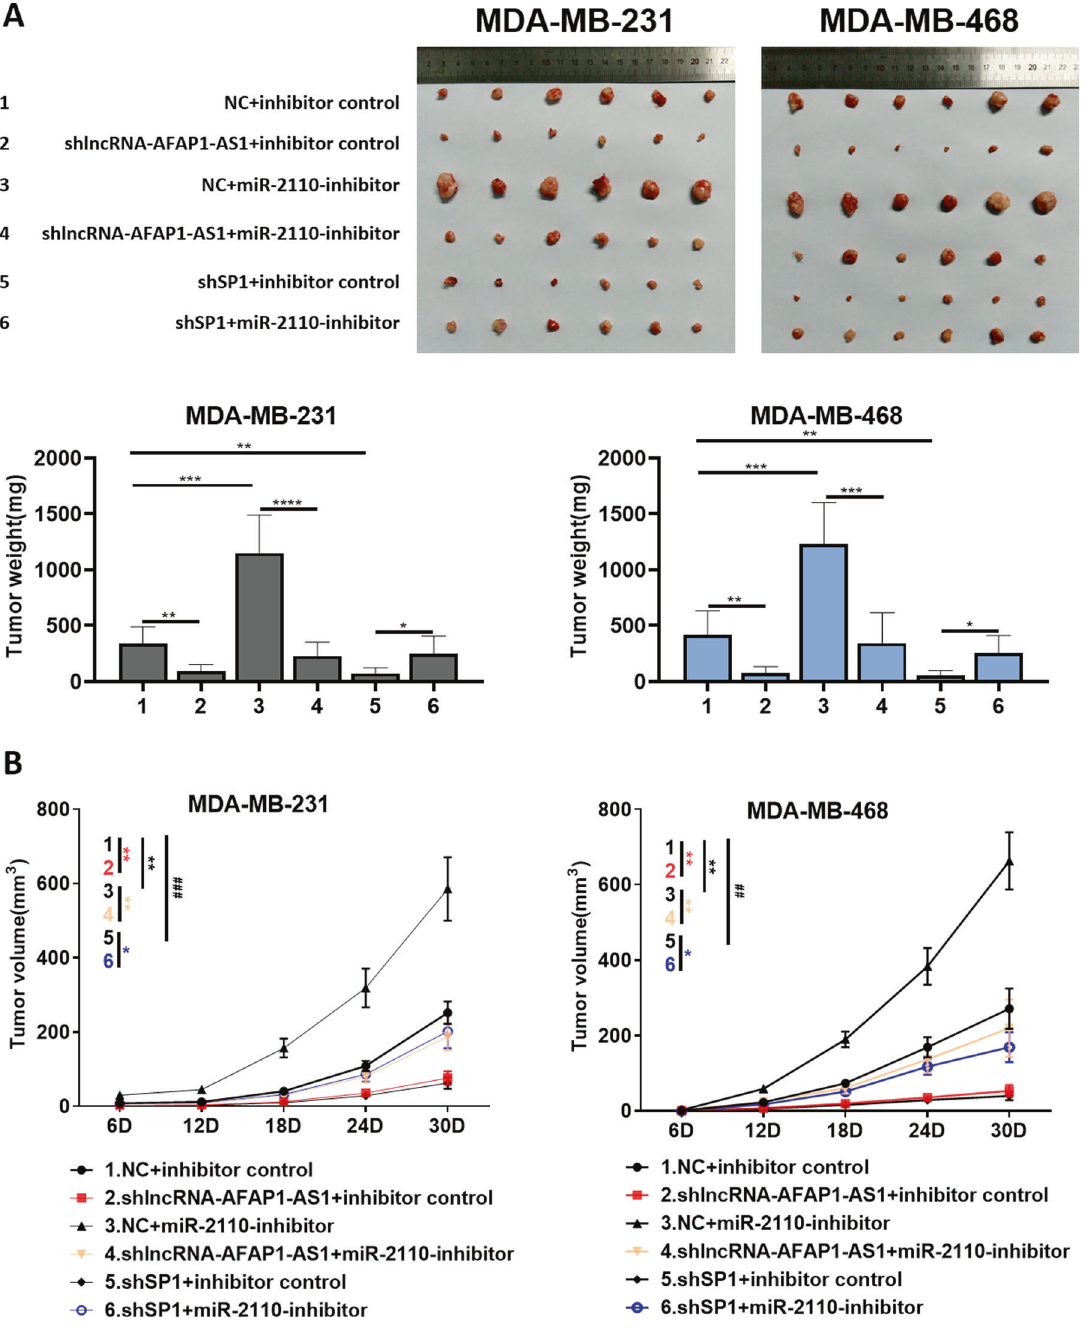
Fig. 5 AFAP1-AS1/miR-2110/ Sp1 affected the tumorigenesis in mice. A Tumor tissues, tumor weight, and B growth curve in each group are shown. Asterisks (*) and hash signs ( # ) represent the signi fi cant analysis between group 1 and group 2 (*), group 1 and group 3 ( * ), group 3 and group 4 (*), group 1 and group 5 ( # ), group 5 and group 6 (*), respectively. Unpaired student ’ s t -test and one-way ANOVA test were used for the statistical analyses. * P < 0.05; ** P < 0.01; *** P < 0.005; **** P < 0.001; ns not signi fi